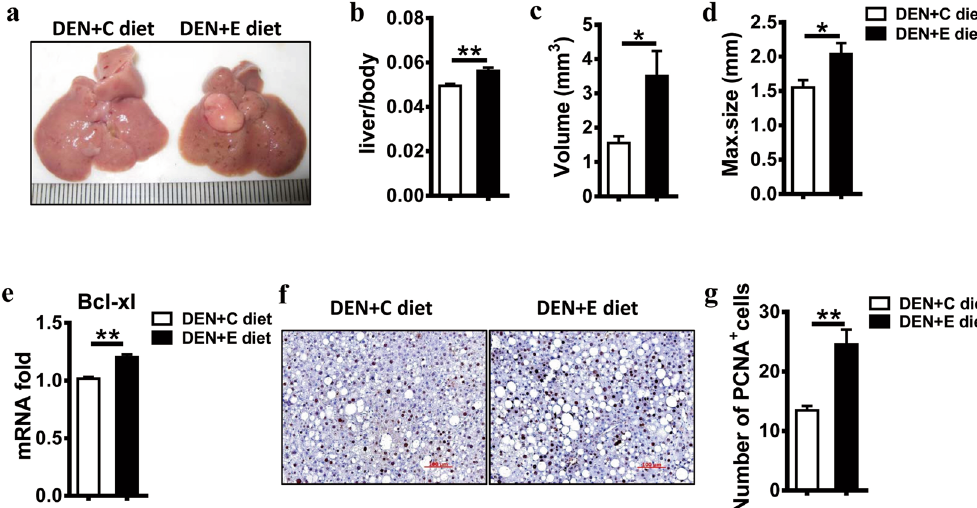
Figure 1. Alcohol consumption promotes DEN-initiated hepatocarcinogenesis in male mice. ( a ) Representative images showing HCC development in male mice given DEN with the control diet (DEN + C diet) or DEN with ethanol feeding (DEN + E diet). ( b ) Liver/body weight ratio was compared with DEN + C diet and DEN + E diet mice. Data are shown as the means ± SEM (n = 8 for DEN + C diet, n = 10 for DEN + E diet). ** P < 0.01. ( c ) Tumor volume was compared with DEN + C diet and DEN + E diet mice. Data are shown as the means ± SEM (n = 10 for DEN + C diet, n = 8 for DEN + E diet). * P < 0.05. ( d ) Greatest tumor diameter was compared with DEN + C diet and DEN + E diet mice. Data are shown as the means ± SEM (n = 10 for DEN + C diet, n = 8 for DEN + E diet). * P < 0.05. ( e ) Bcl-xl mRNA expression in livers were analyzed by Q-PCR in DEN + C diet and DEN + E diet mice. Gene expression level was normalized to housekeeping control β -actin. Data are shown as the means ± SEM (n = 3 for DEN + C diet, n = 6 for DEN + E diet). ** P < 0.01. ( f ) Cell proliferation levels assessed through PCNA staining (original magnification, 200 × . Scale bar, 100 μ m). ( g ) The number of PCNA-positive cells per field were compared with DEN + C diet and DEN + E diet mice. Data are shown as the means ± SEM (n = 4 for DEN + C diet, n = 5 for DEN + E diet). ** P <